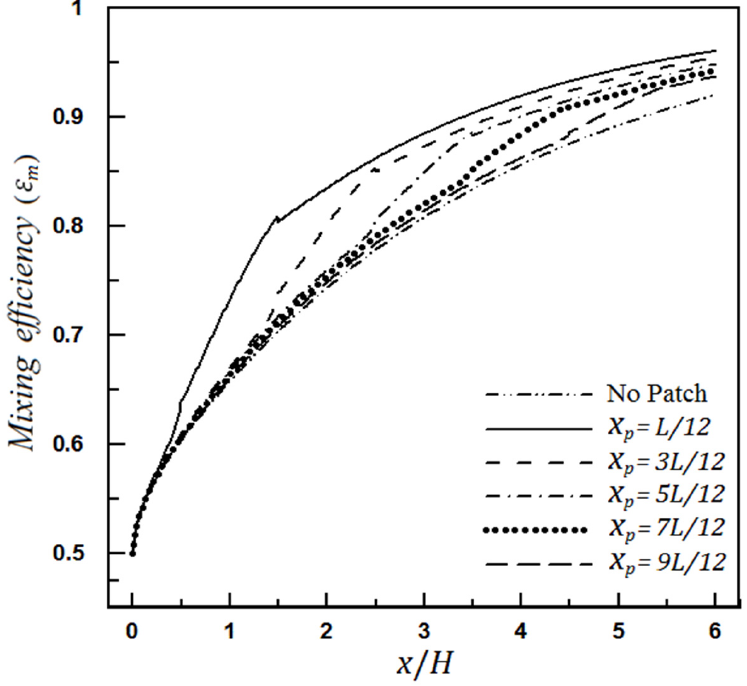
Figure 9. The effect of position changing of the heterogeneity patch on mixing efficiency (the length of heterogeneity patch, L (cid:2926) = L 6⁄ ).